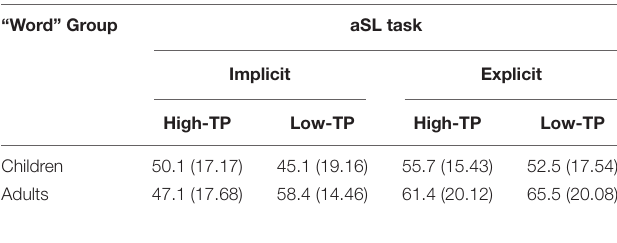
TABLE 2 | Mean (SD) of the number (%) of correct responses for the high- and low-TP “words” in the implicit and explicit aSL tasks per group of participants. “Word”